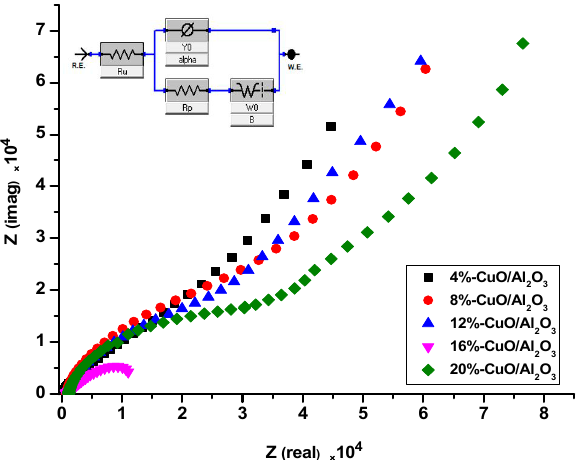
Figure 5. Electrochemical impedance spectroscopy (EIS) spectra for 4%–20%-CuO/ γ -Al 2 O 3 elec- trodes recorded in 1 M NH 3 + 0.1 M KOH aqueous solutions. Inset represents the model fit for calculating parameters. Table 2. Parameters estimated from EIS analysis of